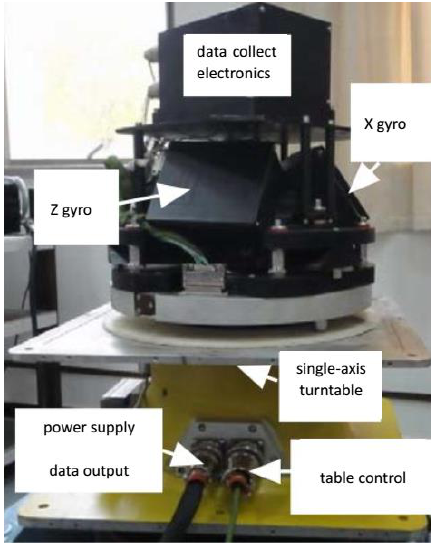
Figure 3. Simulation results under angular vibrations with an amplitude of 10 arcsec and a random frequency between 5 and 10 Hz. ( a ) 1 − final azimuth error when the total alignment time T changes from 30 to 300 s. ( b ) Azimuth error curve when the total alignment time is 180 s.